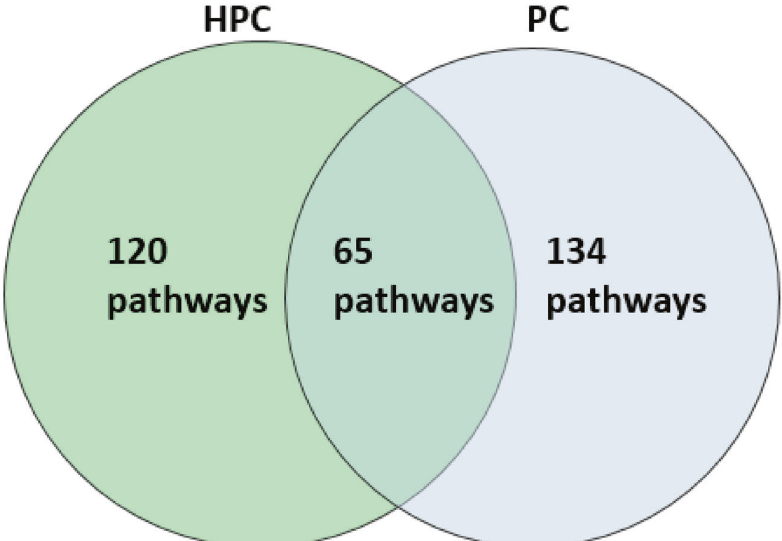
Fig. 2 The overlap in the pathways enriched by GeneAnalytics [18], between the GWAS-based extended lists of the hippocampal (HPC) (GSE53987) and parietal cortex (PC) (GSE35978) datasets. For the respective datasets, 120 and 134 pathways were found to be enriched by GeneAnalytics. The size of the overlap between the resulting enriched pathways of the two datasets, 65, corresponds to a hypergeometric p value of 1.69 × 10 − 34